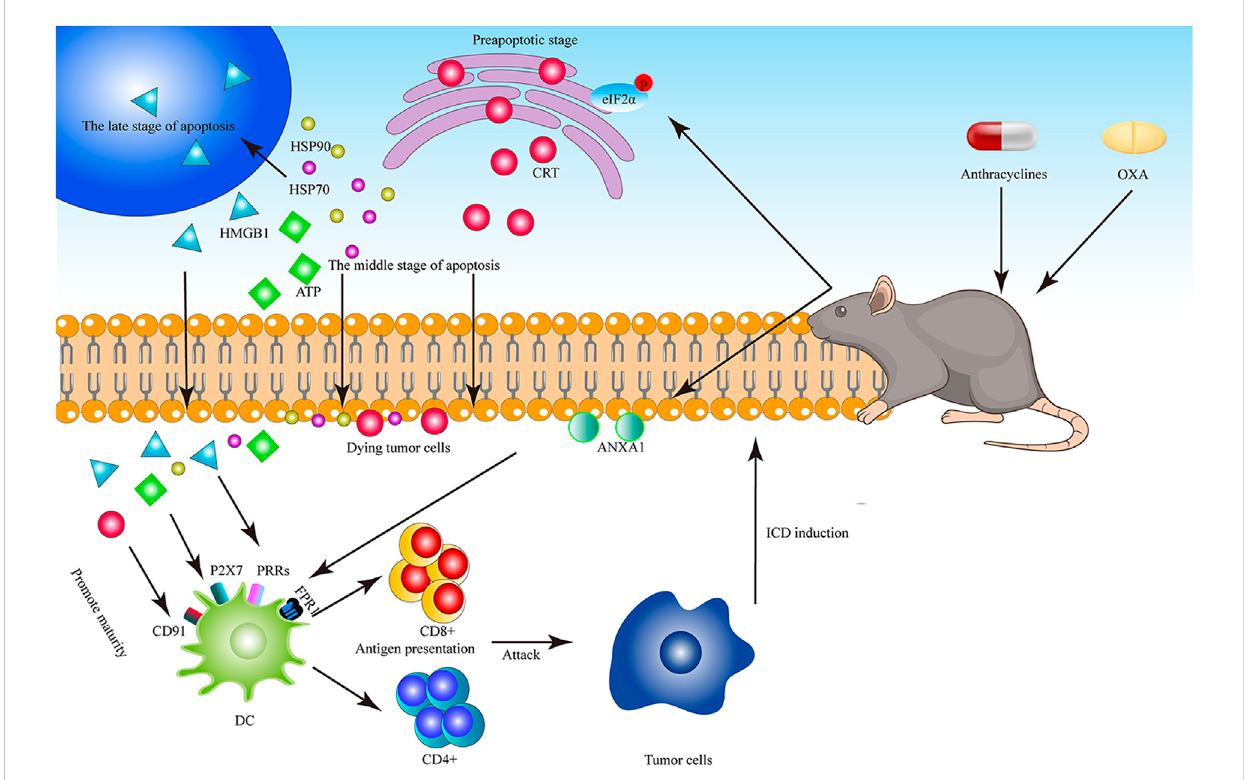
FIGURE 2 The diagram of Anthracyclines and OXA to induce ICD. Anthracyclines and OXA cause phosphorylation of EIF2A in dying tumor cells, and induce CRT translocation in the early stage of apoptosis, ATP secretion, HSP70 release in the middle stage of apoptosis and HMGB1 release in the late stage of apoptosis. CRT iscombined with CD91, ATP is combined with P2x7, and HMGB1 is combined with TLR4. In addition, ANXA1 on the surface of tumor cells and FPR1 on the surface of DC are stably combined with the forming cells to promote the maturation of DC, and DC presents antigens to T cells, further killing tumor